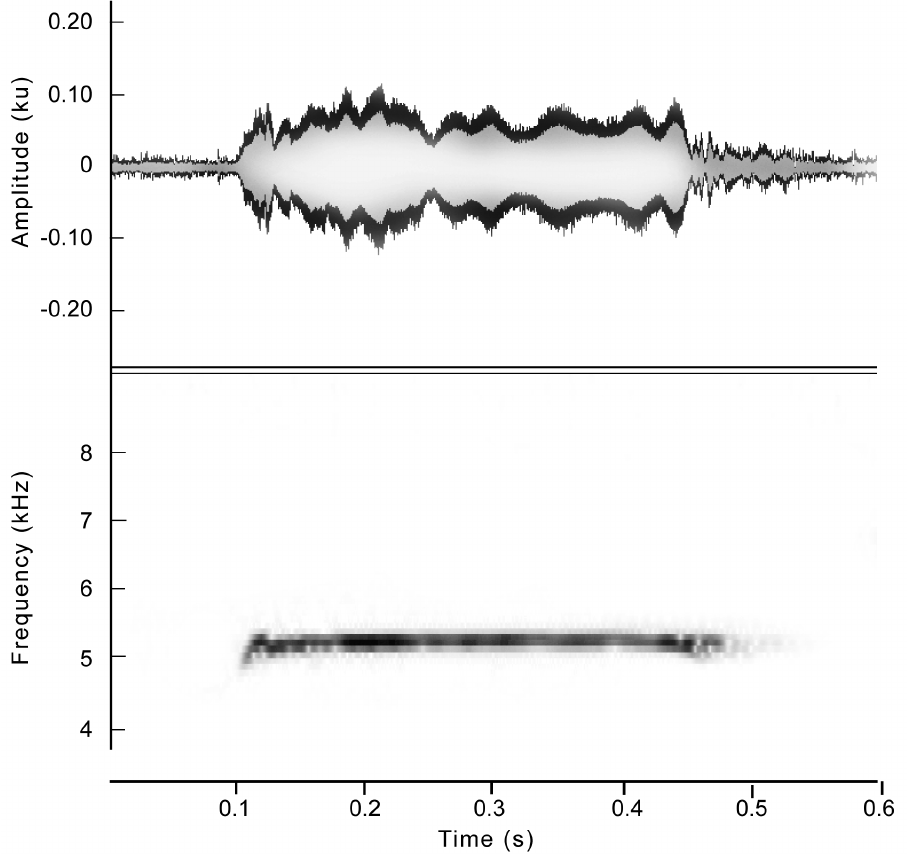
Figure 5. Call of Hyalinobatrachium yaku sp. n.,